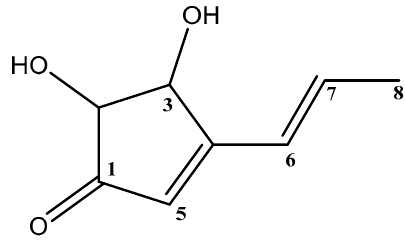
Figure 3. The structure of terrein.